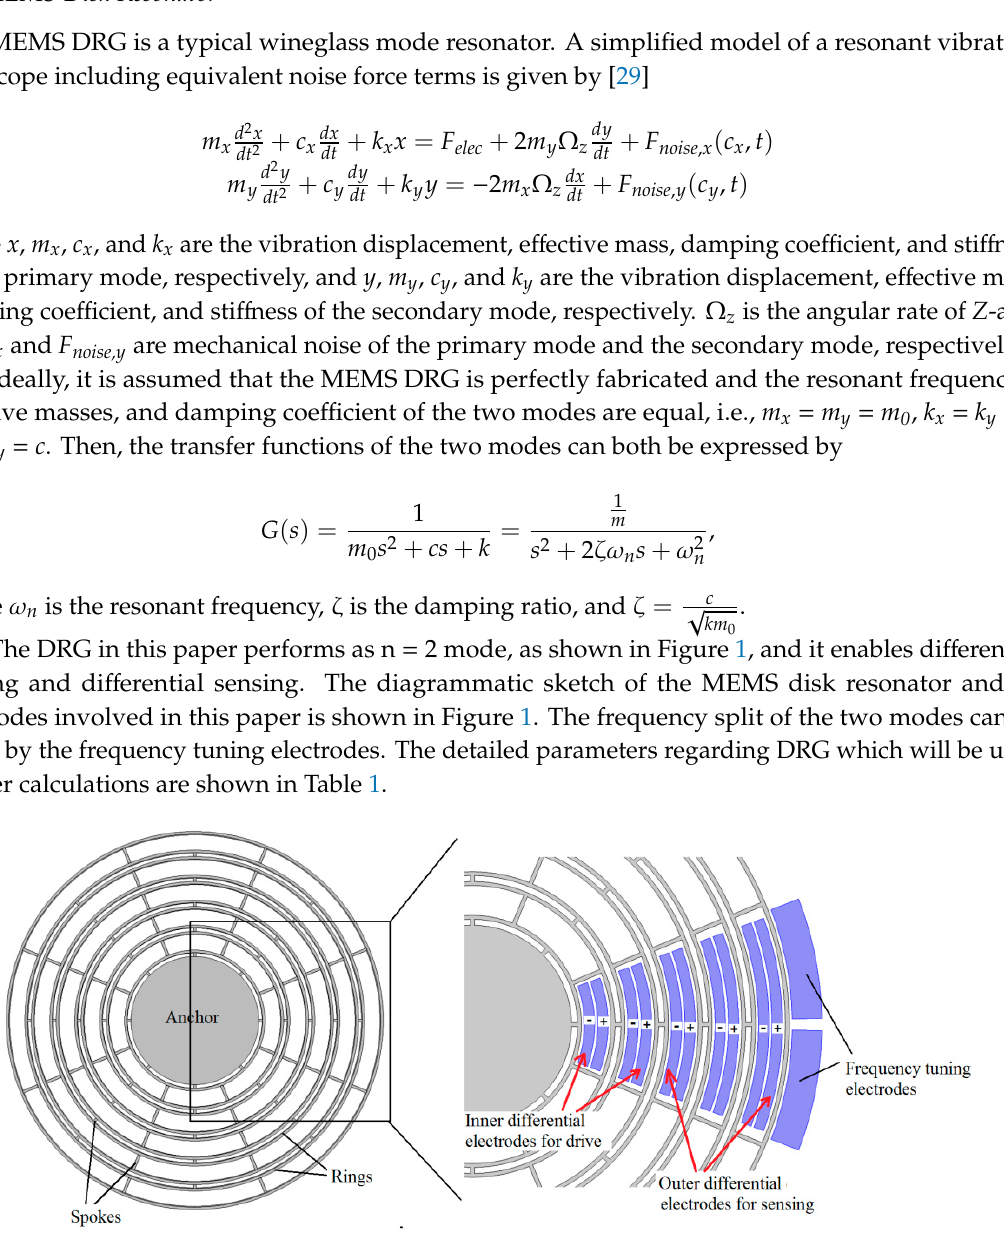
Figure 1. Diagrammatic sketch of MEMS disk resonator.